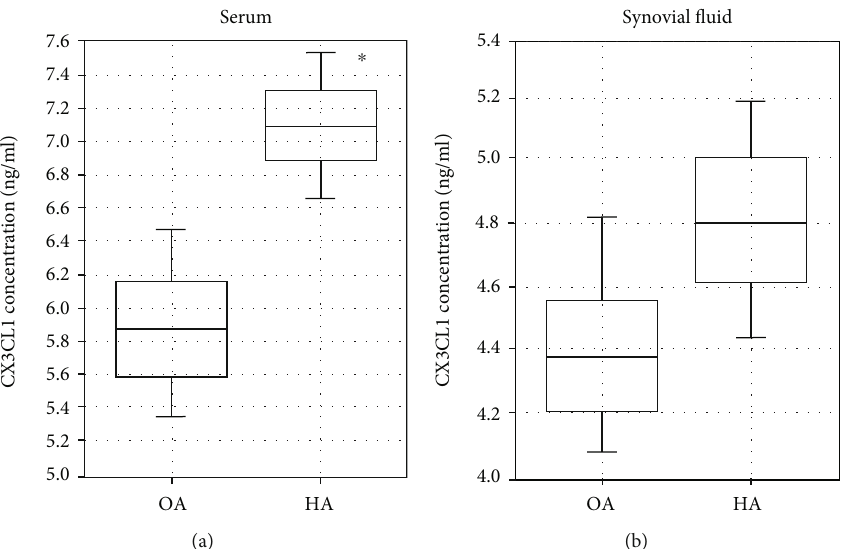
Figure 1: The average concentration of the CX3CL1 in serum (a) and synovial fl uid (b) obtained from patients. The data has been presented as a mean value ± standard deviation (SD). ∗ p < 0 : 05 . OA: osteoarthritis; HA: hemophilic arthropathy.